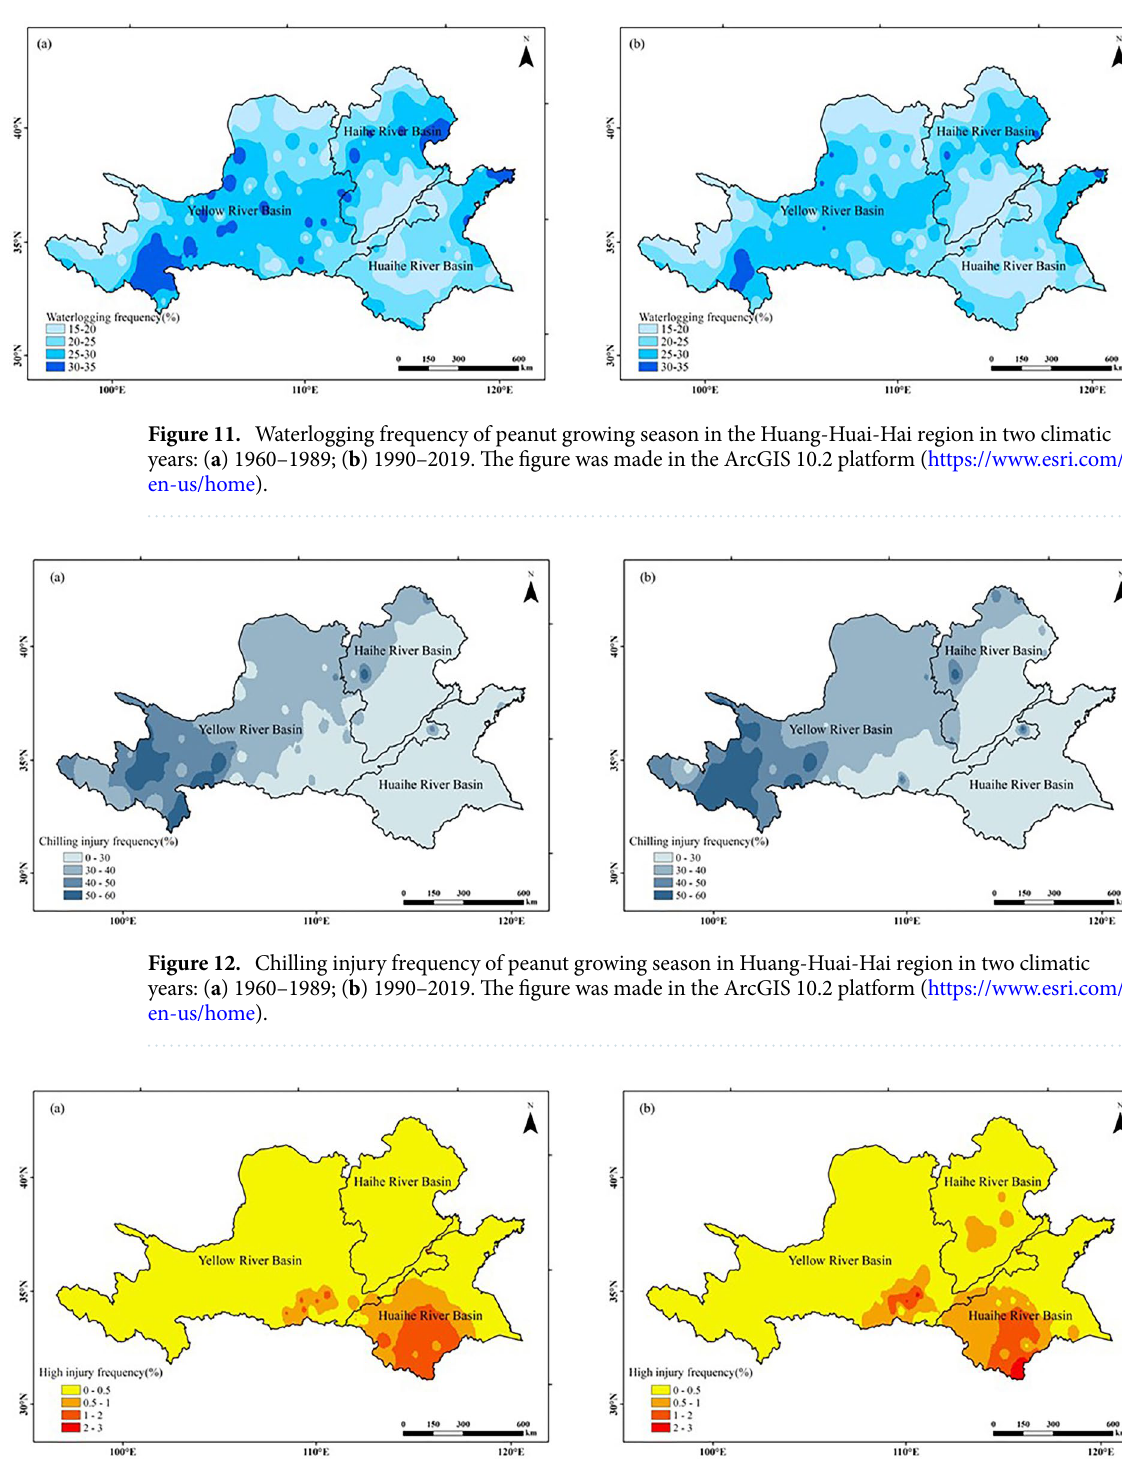
Figure 13. Heat injury frequency of peanut growing season in Huang-Huai-Hai region in two climatic years: ( a ) 1960–1989; ( b ) 1990–2019. The figure was made in the ArcGIS 10.2 platform (https:// www. esri. com/ en- us/